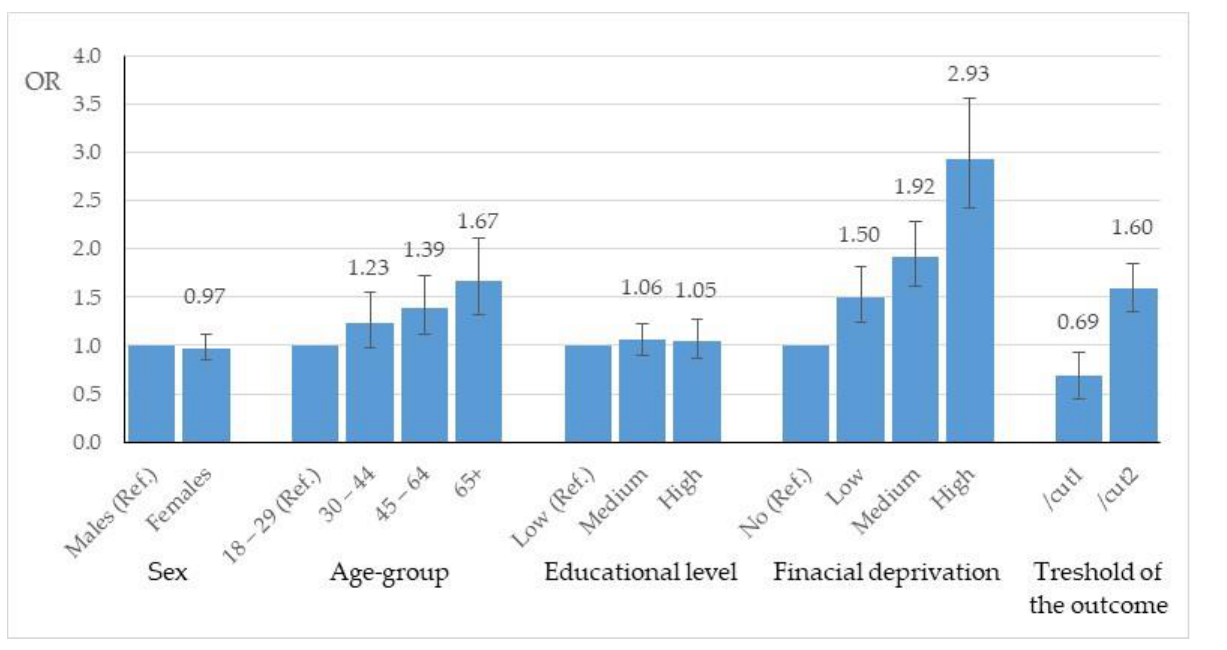
Figure 1. Association between HL-COVID main score level and participant characteristics (sex, age, education, financial deprivation) in terms of odds ratio (OR) with 95% confidence interval.